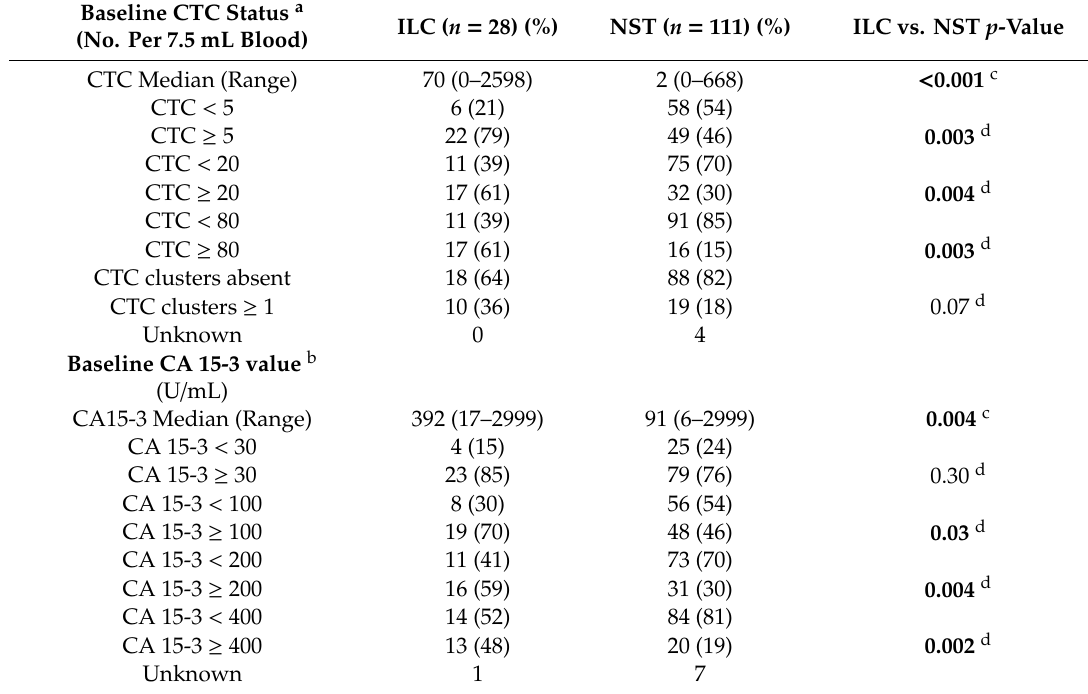
Figure 3. Distribution of CTC counts at baseline and with serial sampling at different time points. Spaghetti plots showing number of CTCs (per 7.5 mL blood) per patient from baseline (BL) to 6 months of follow-up for invasive lobular carcinoma (ILC), left panel ( A ), and invasive ductal carcinoma of no special type (NST), right panel ( B ). The p -values correspond to pairwise tests of the null hypothesis of no change in CTC count (Wilcoxon matched-pairs signed-rank test). Note that the scale on the y-axis is logarithmic and that the y-axis has been broken to enable presentation of zeros. A small amount of random noise was added to all zeros to separate the lines. The red line connects the medians at the four time points. Table 2. Baseline CTC and CA 15-3